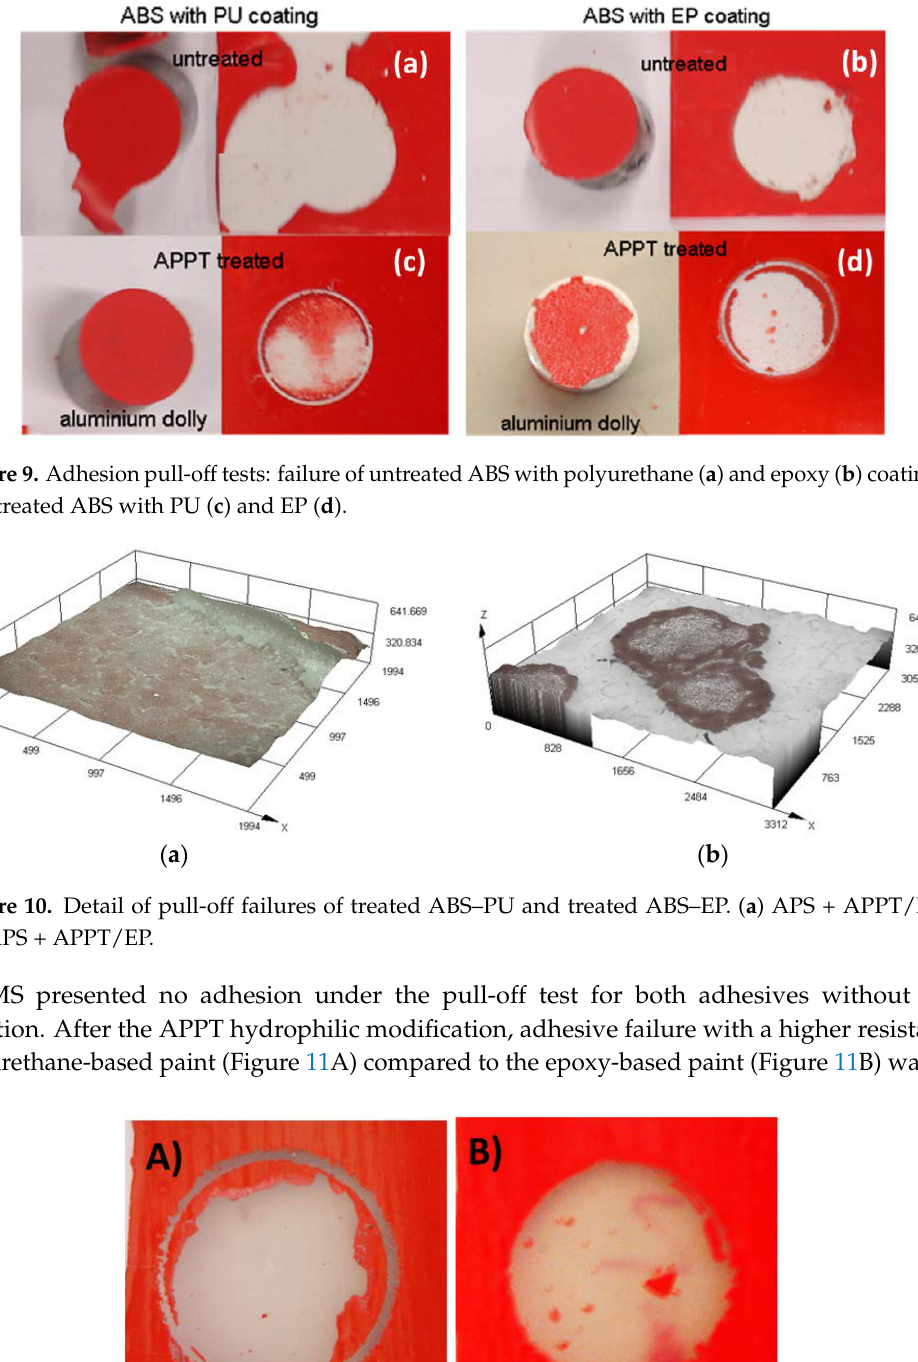
Table 4. Adhesion strength (kPa) by adhesion pull-off test.